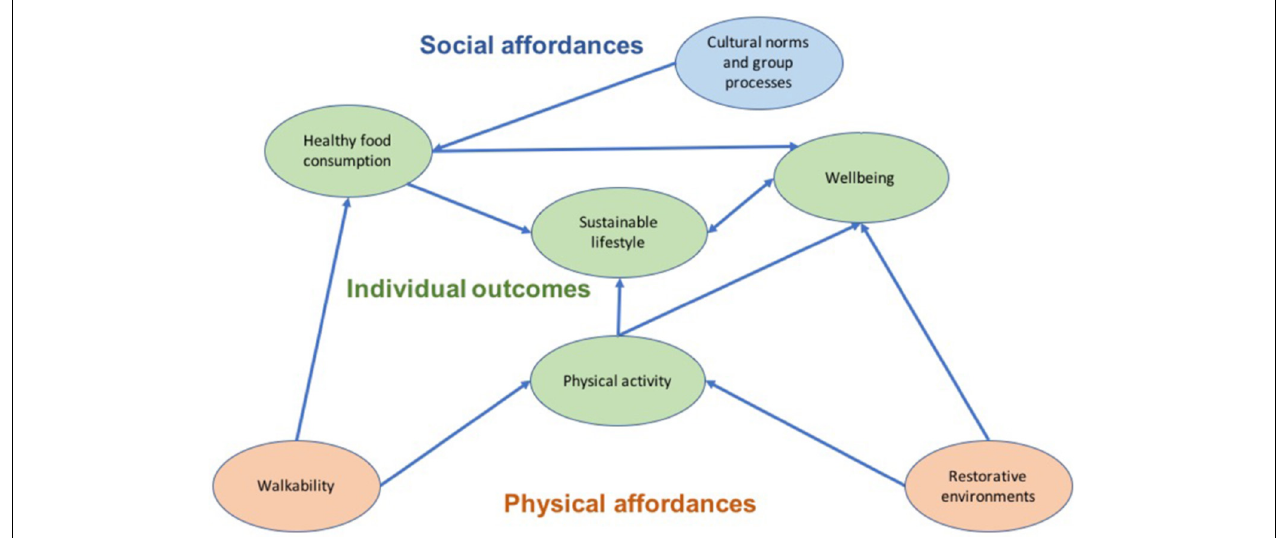
FIGURE 1 | A conceptual